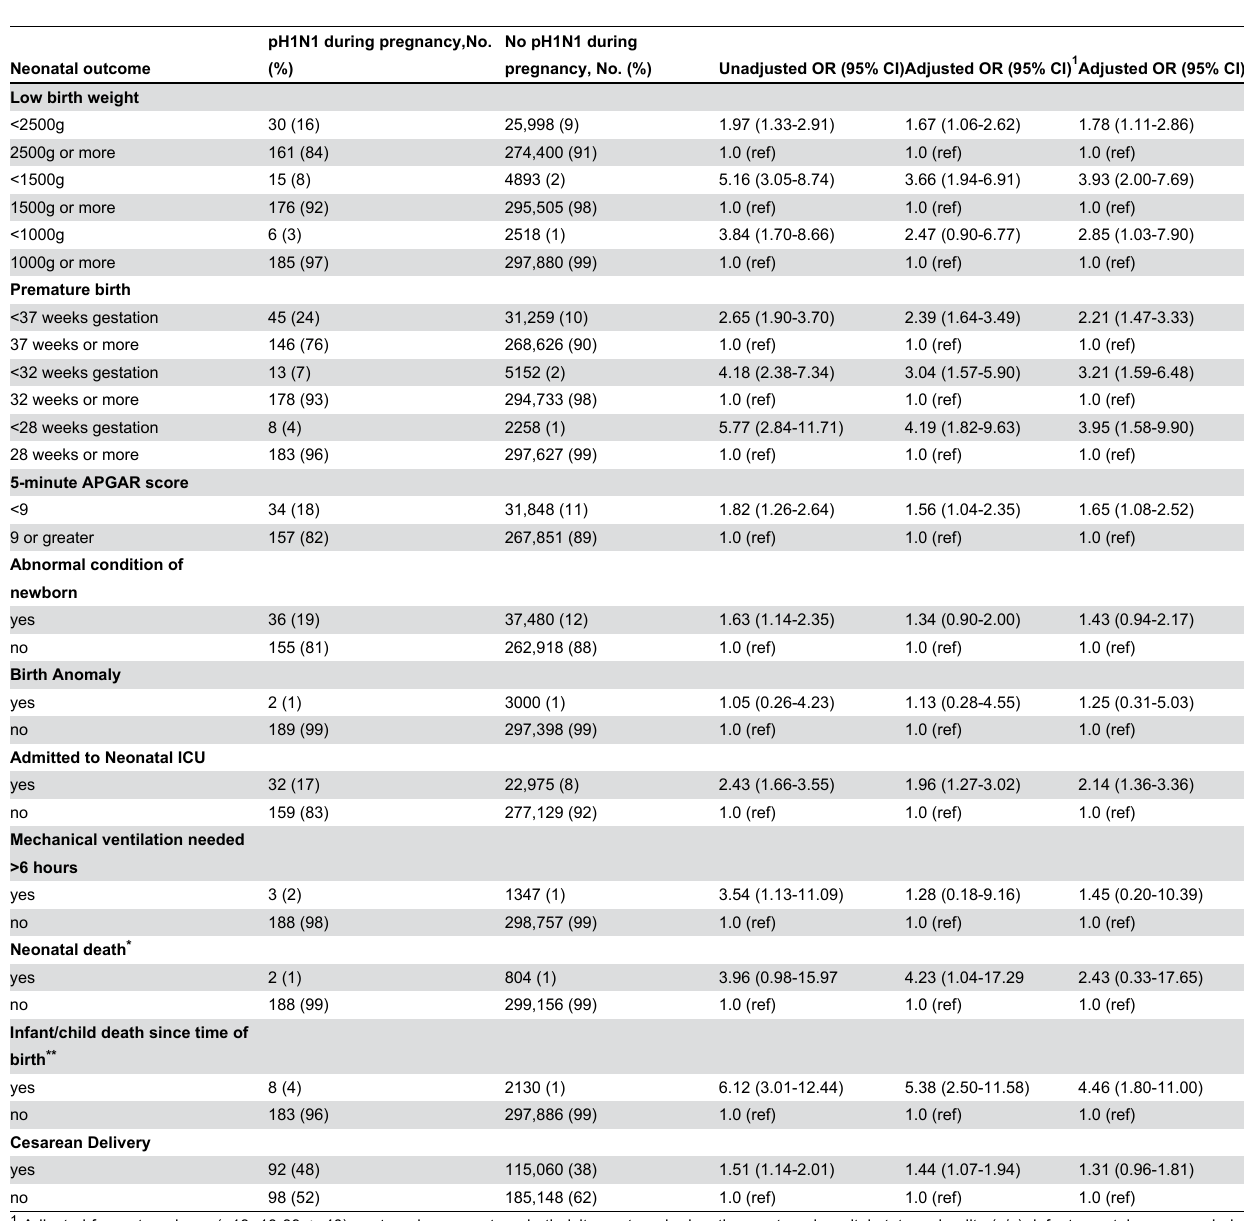
Table 3. Neonatal outcomes associated with pandemic influenza illness during pregnancy.